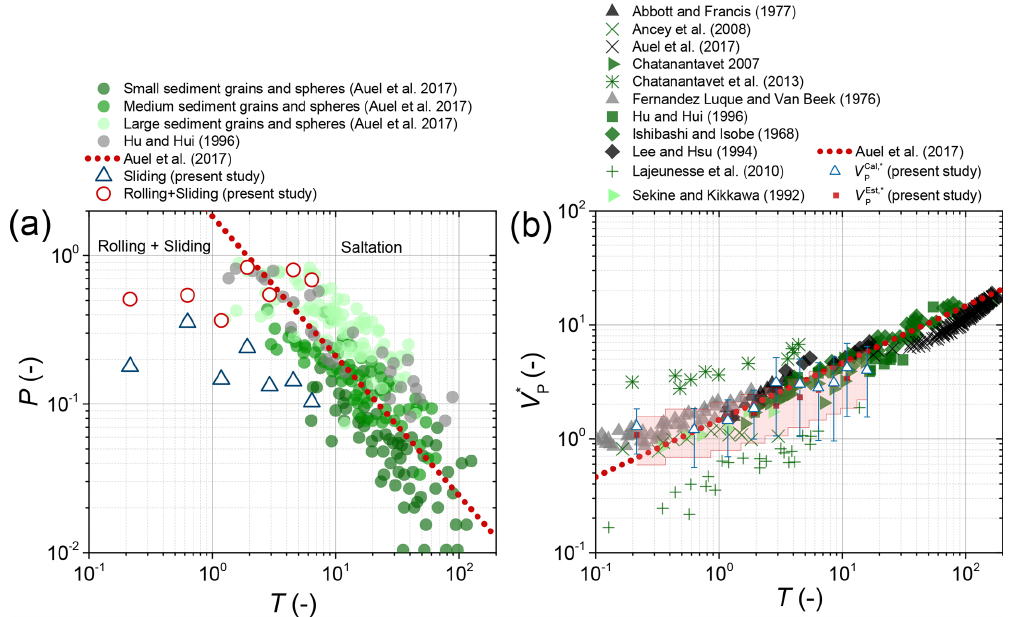
Figure 12. (a) Probability of transport mode P ( P Sal for saltation, P Rol for rolling, and P Sli for sliding) as a function of the excess transport stage T . The data from Auel et al. (2017a), associated with natural grains and spheres with variable sizes ranging from about 5.3 to 17.5mm, are shown in green. The data from Hu and Hui (1996) are presented in gray. The present results from our flume experiments with T ranging from 0.22 to 6.42 are compared to the power-law model P = 184 T − 0 . 94 (with R 2 = 0 . 64) applied by Auel et al. (2017a) (dotted red line), √ = 146 T 0 . 5 = V P / ( s − 1) gD versus T . The power-law model V ∗ and their compiled data. (b) The nondimensional particle velocity V ∗ P P (with R 2 = 0 . 95) applied by Auel et al. (2017a) is shown as a dotted red line. The transparent red-shaded area indicates the variability of the ∗ particle velocity V Est , estimated as 30%–80% of the flow velocity, as suggested by Julien and Bounvilay P